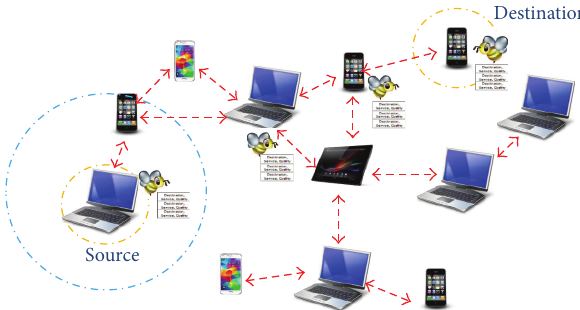
Figure 1: Mobile ad hoc network with routing via bee